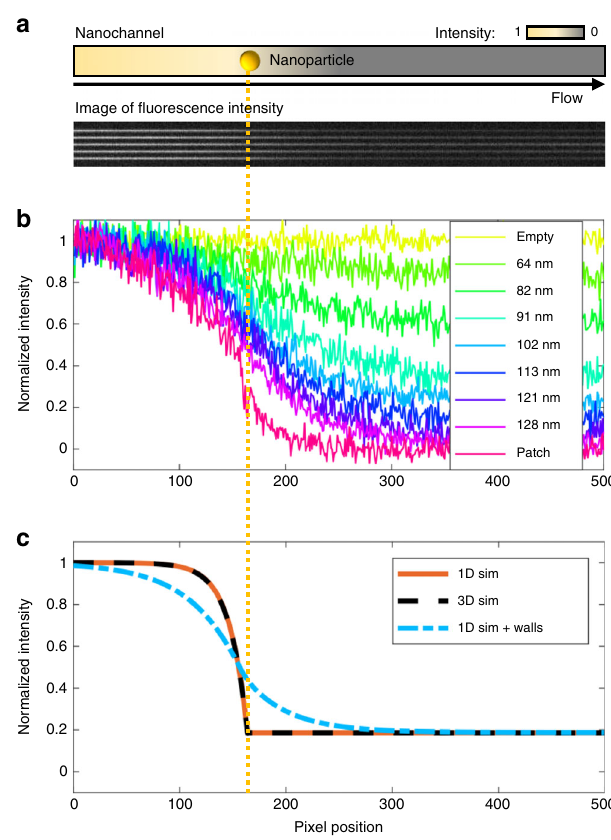
Fig. 2 Fluorescence intensity distributions during reaction. a Schematic depiction of the fl uorescence intensity distribution along a nanochannel containing a nanoparticle at the marked position together with a corresponding real fl uorescence image of a set of fi ve nanochannels, each containing a nanoparticle with a diameter of 121 nm. Note the decrease in fl uorescence intensity downstream of the nanoparticles. b Normalized, with respect to the average of all empty reference channels, experimentally measured, fl uorescence intensity pro fi les along different sets of nanochannels, depicted as the mean value of 5 channels for each particle size. For all channels, the catalyst particle is located at pixel position 164 (yellow dotted line). c Fluorescence intensity pro fi les simulated in 1D (orange line) and in 3D (dashed black line), as well as in 1D with wall adsorption, desorption, and diffusion (blue dash-dotted